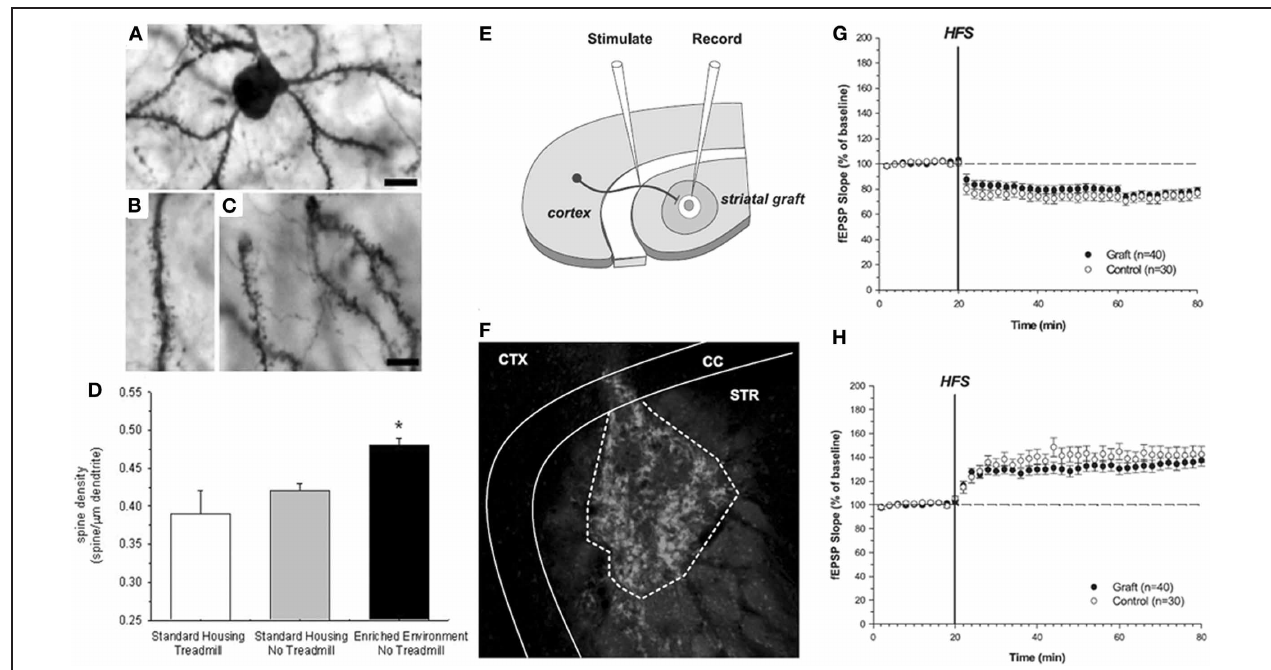
C = 25 μ m; (E–H) . The corticostriatal “ in vitro “-graft preparation. (E) Schematic representation of electrode positions within the striatal graft in vitro slice preparation. (F) Photomicrograph demonstrating the endogenous GFP fluorescence of the transplanted tissue within the striatum. CTX, cortex; CC, corpus callosum; STR, striatum. (G–H) Extracellularly recorded synaptic plasticity. (G) Expression of LTD in graft and control recordings. (H) Expression of LTP in graft and control recordings. HFS, high-frequency stimulation Mazzocchi-Jones et al.